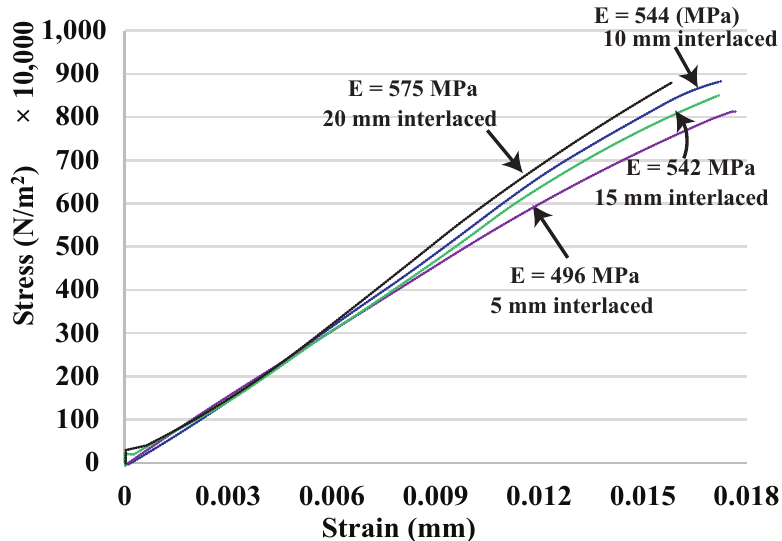
Figure 16. Tensile test curves for different sizes of